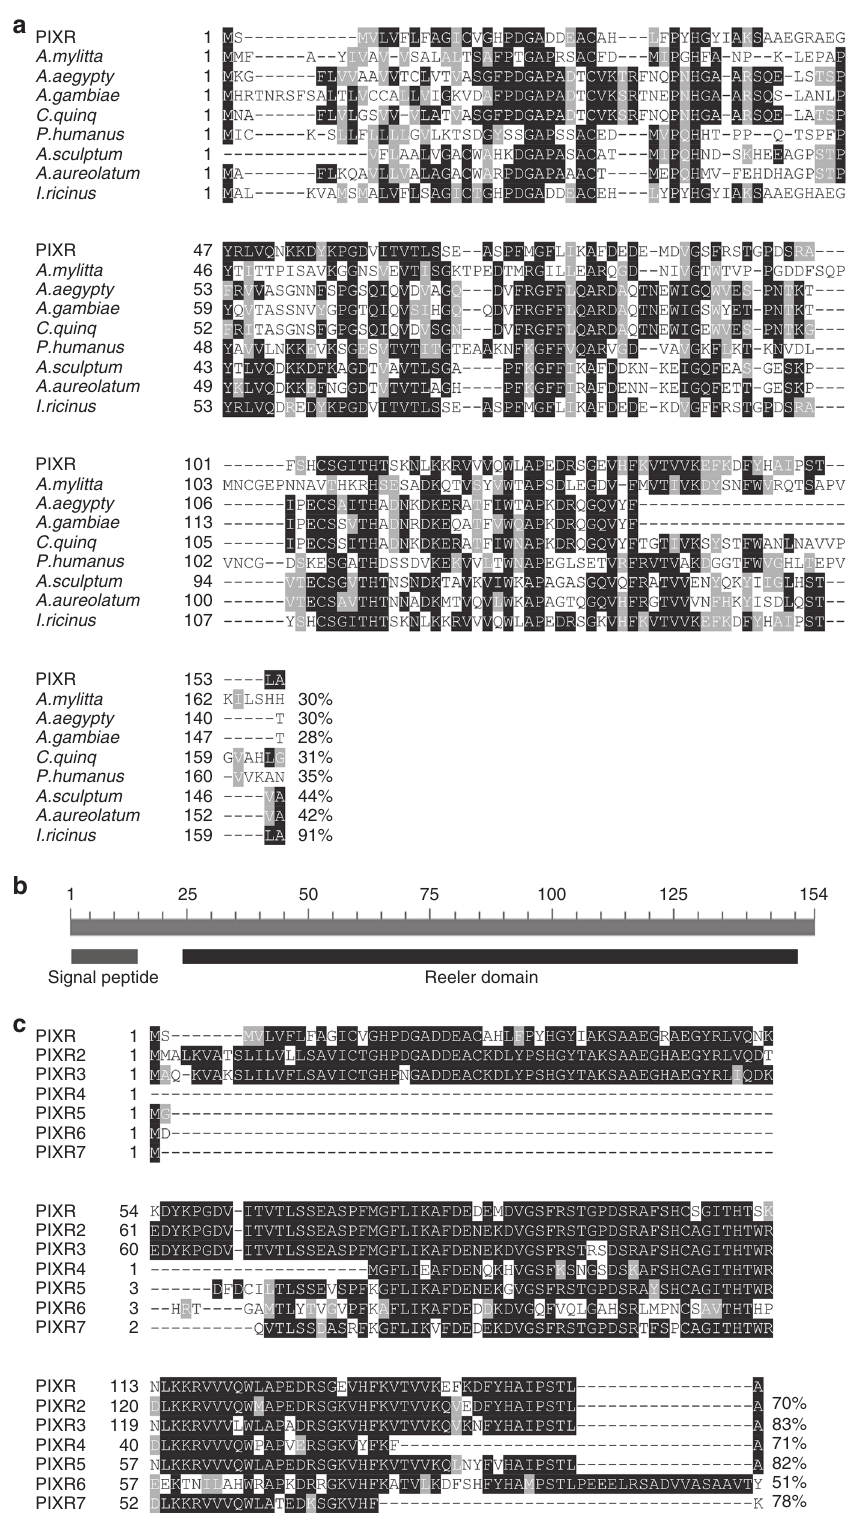
Fig. 1 PIXR and its homologs in arthropods. a Multiple sequence alignment of Ixodes scapularis PIXR with the amino acid sequences of several homologs identi fi ed in Antheraea mylitta (GenBank accession code ABG72705) , Aedes aegypti ( GenBank EAT35239), Anopheles gambiae (GenBank XP_315224), Culex quinquefasciatus (GenBank XP_001849402) and Pediculus humanus (GenBank XP_002426361) , Amblyomma sculptum (GenBank JAU03031) , Amb. aureolatum (GenBank JAT91861) and I. ricinus (GenBank JAP74644). Amino acids in white on a black background are identical; residues in white on a gray background are similar. Similarities and identities to PIXR are presented at the end of the amino acid sequences. b Schematic overview of PIXR showing that the mature protein for the greater part consists of a Reeler domain. Scale bar represents number of amino acids. c Multiple sequence alignment of I . scapularis PIXR with the amino acid sequences of paralogs identi fi ed in the I . scapularis genome